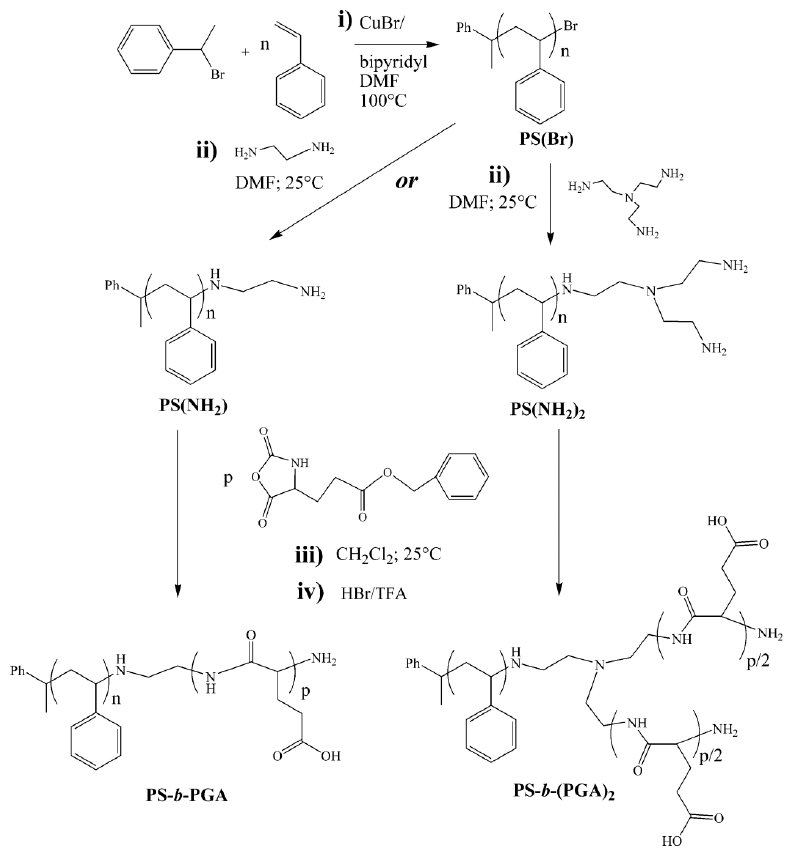
Figure 45. Synthetic strategy for miktoarm star hybrid-copolypeptides reported by Babin et al. Reproduced with permission from reference [11].